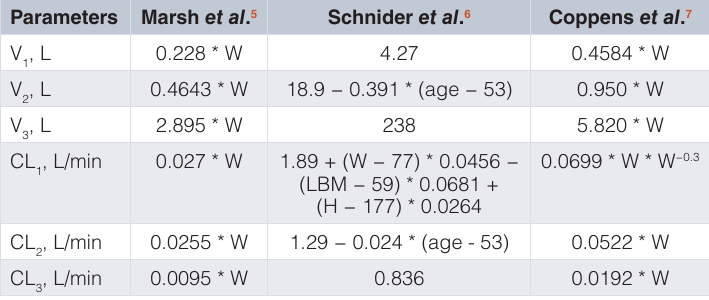
Table 1. Some of the numerous models published for propofol. Parameters Marsh et al .